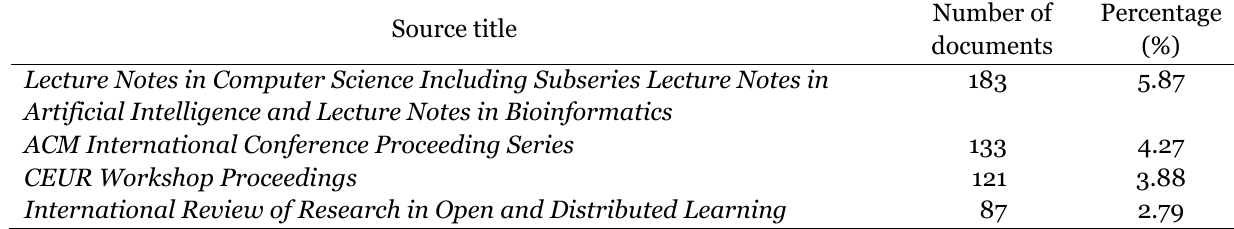
Top 20 Sources for MOOCs